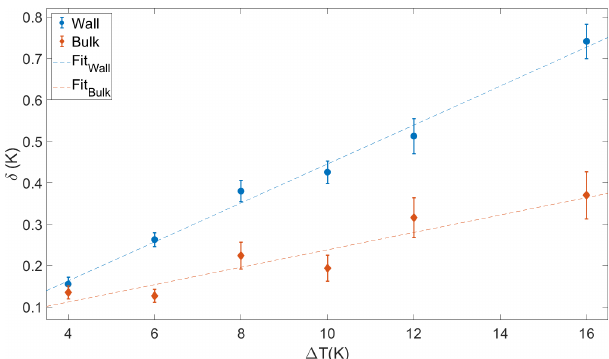
Figure 9. The amplitude, δ , of the large-scale circulation along the wall (red) and 30cm towards the center (blue) for a range of (cid:49)T s. The dashed lines are the linear fits to the wall ( y = 0 . 047 (cid:49)T − 0 . 25) and the bulk ( y = 0 . 021 (cid:49)T + 0 . 028). The uncertainties correspond to ± σ δ ((cid:49)T ) . At each (cid:49)T , δ is higher along the wall than in the